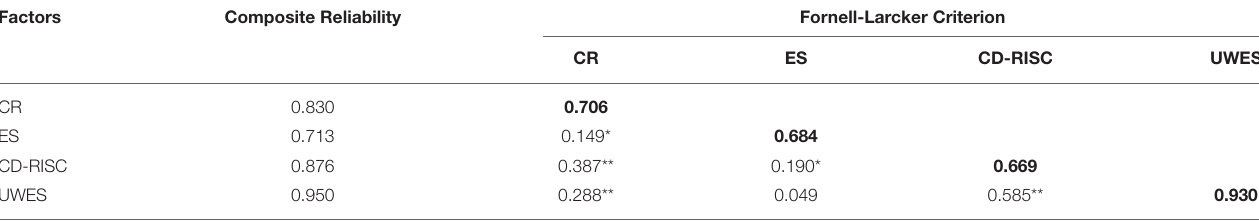
TABLE 2 | Composite reliability and discriminant validity of the factors.